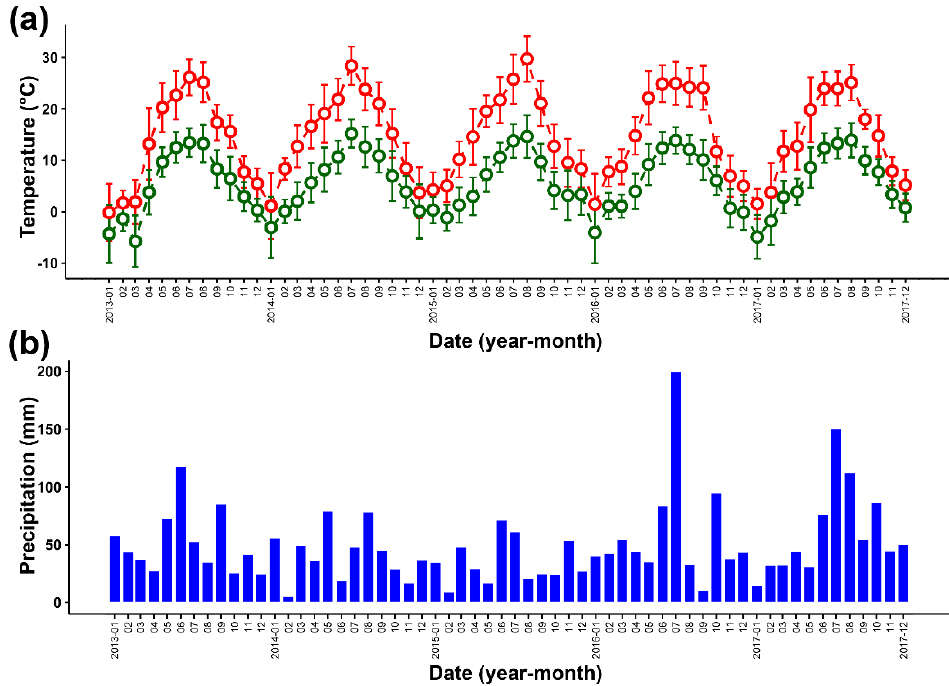
Figure 9. Meteorological conditions during the period of seed development. ( a ) Monthly maximum (red) and minimum (green) mean values of air temperature (°C). ( b ) Monthly mean of the total precipitation (mm).